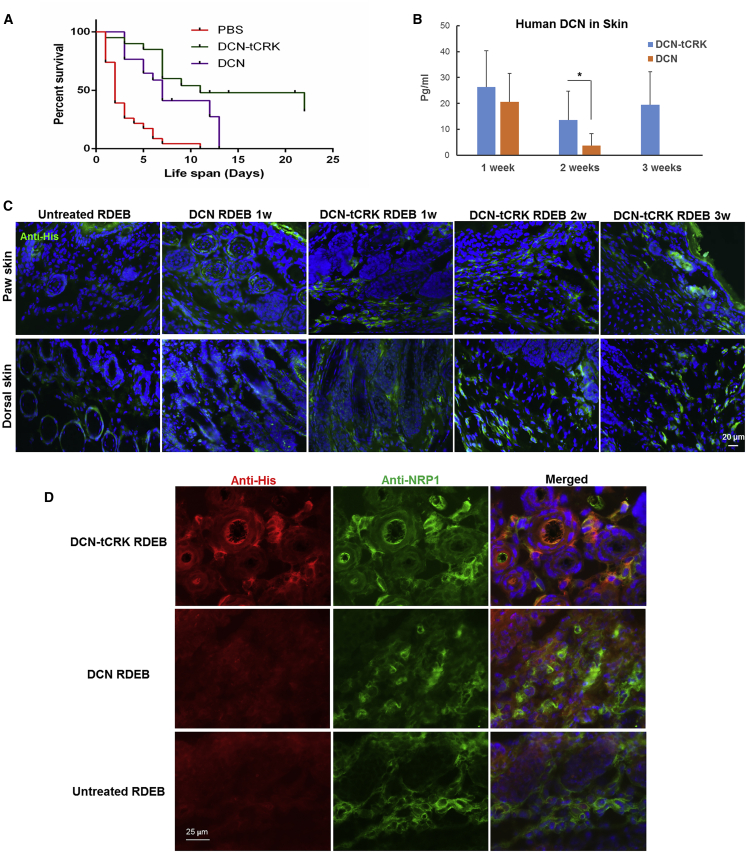
DCN-tCRK Improves Survival of col7a1−/− Mice and Homes to the Skin(A) Kaplan-Meier survival analysis of the col7a1−/− mice that received DCN-tCRK (median lifespan, 11 days; n = 21; green line), DCN (median lifespan, 7 days; n = 17; purple line), and PBS (median lifespan, 2 days; n = 24; red line) administration. (B) Quantitation on the levels of DCN and DCN-tCRK, determined using a human decorin ELISA kit, in the skin of recipient col7a1−/− mice at 1 week, 2 weeks, and 3 weeks after intrahepatic administration (n = 3 per time point). There was no quantitation on the level of DCN at the 3-week time point, as no mice survived until that time after DCN administration. Error bars represent SEM. ∗p < 0.05, ∗∗p < 0.01. (C) Immunohistochemical staining using anti-histidine antibody (anti-his; green) on both paw and dorsal skin of col7a1−/− mice is presented. Nuclei were counterstained with DAPI (blue). Scale bar, 20 μm. (D) Representative double staining of anti-histidine tag (red) and anti-NRP-1 (green) and the merged image (with DAPI counterstain; blue) of the DCN-tCRK-treated, DCN-treated, and untreated RDEB skin are presented. Scale bar, 25 μm.